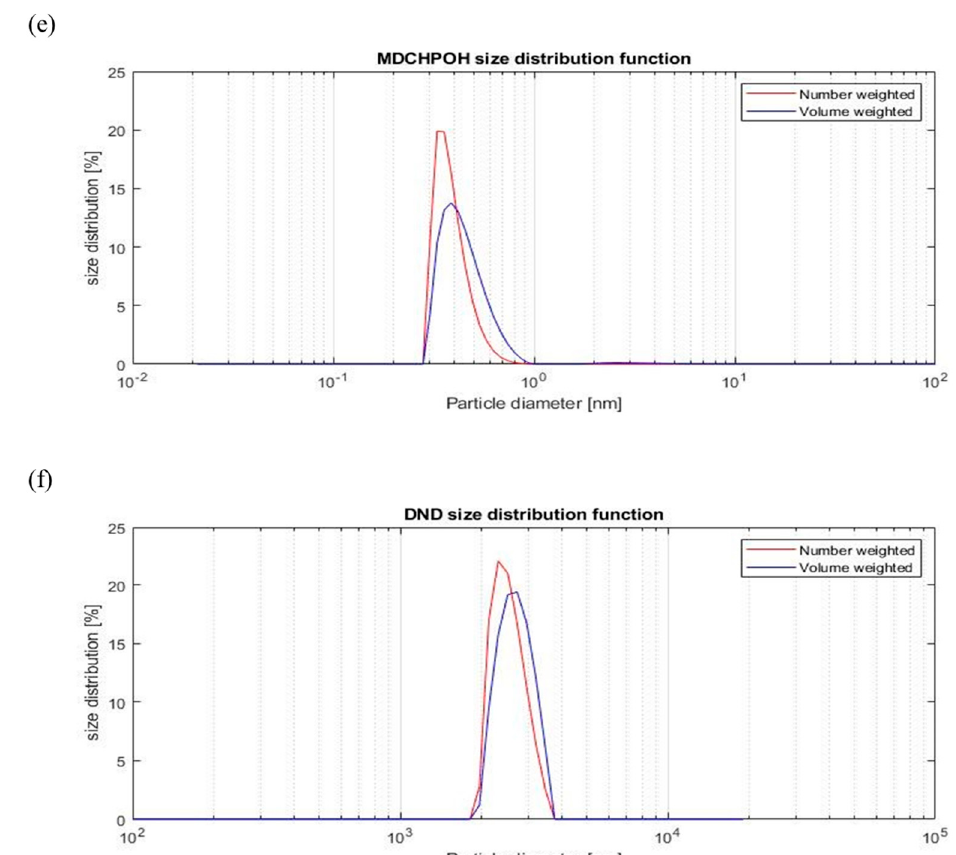
Figure 7. CBNs particle size based on DLS analysis (distribution function depending on number or volume weight): ( a ) Graphene Oxide (GO) film; ( b ) amorphous carbon powder formed using Radio Frequency Plasma Activated Chemical Vapor Deposition Method (RF); ( c ) fluorescent nanodiamond (MDCHF), ( d ) plasma–chemically modified detonated nanodiamond particles (MDP1); ( e ) chemically modified detonated nanodiamond particles with hydroxyl functional groups (MDCHPOH); ( f ) pure detonated nanodiamond particles (DND).